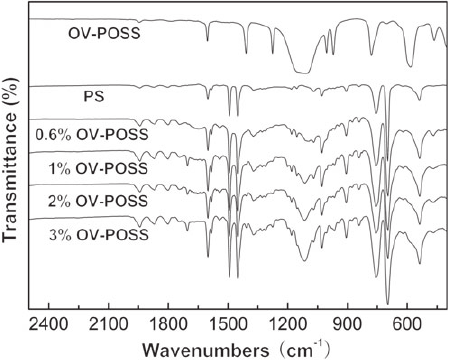
Figure 2 FTIR spectra for OV-POSS, neat PS, and PS-OV-POSS com- posites with various OV-POSS